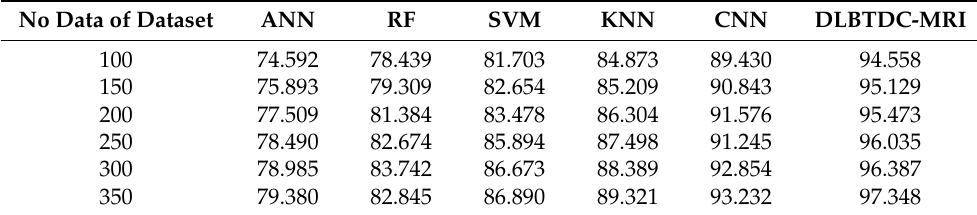
Table 6. Execution time analysis of DLBTDC-MRI method with existing system.